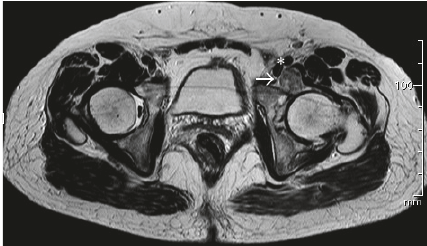
Figure 8: T1-weighted axial image of extra-articular loose bodies (arrow) adjacent to the iliopsoas muscle and the femoral vessels (asterisk).